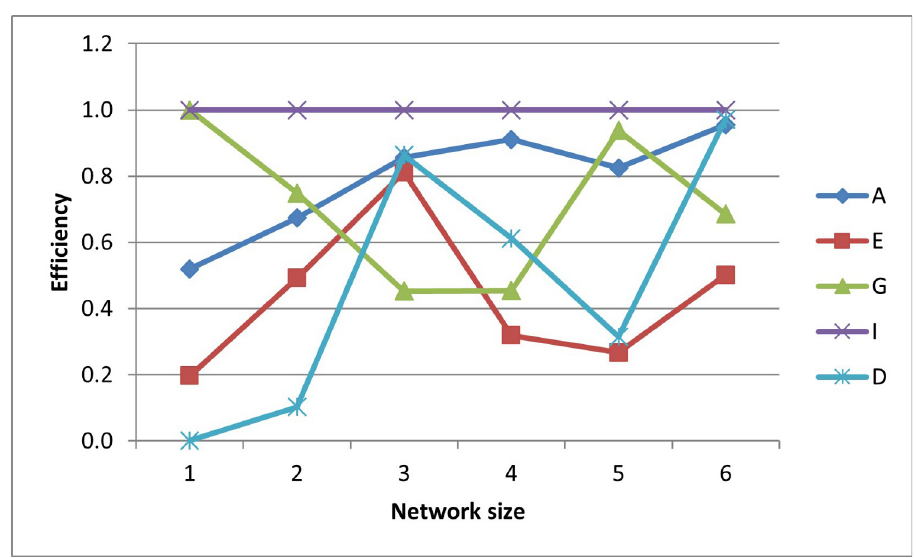
Fig 10. I-efficiencies of various optimal designs for the first case